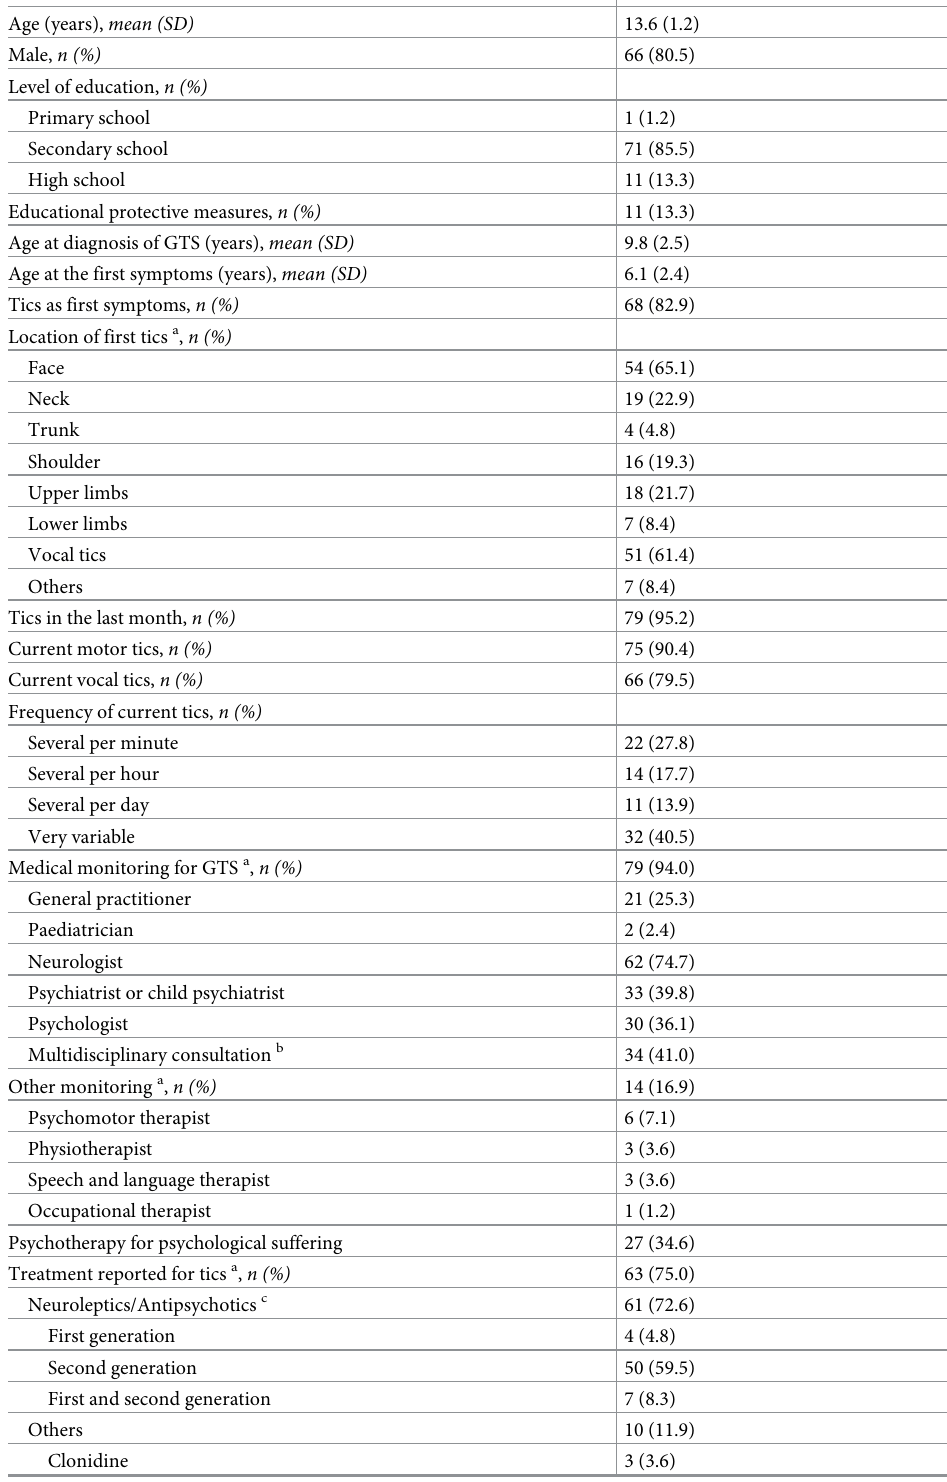
Table 1. Sociodemographic and clinical characteristics of the